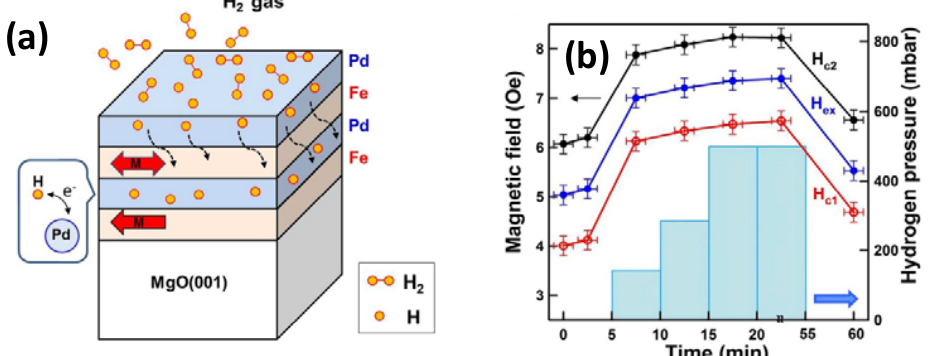
Figure 11. ( a ) Schematic diagram of the effect of hydrogenation on Pd-covered Fe/Pd/Fe trilayers on Mg(001) substrate. ( b ) Left: magnetic field; right: corresponding H 2 gas pressure in the measurement environment, “Reprinted/adapted with permission from Ref. [104]. 2018, Hsu, C.-C. et al.”.